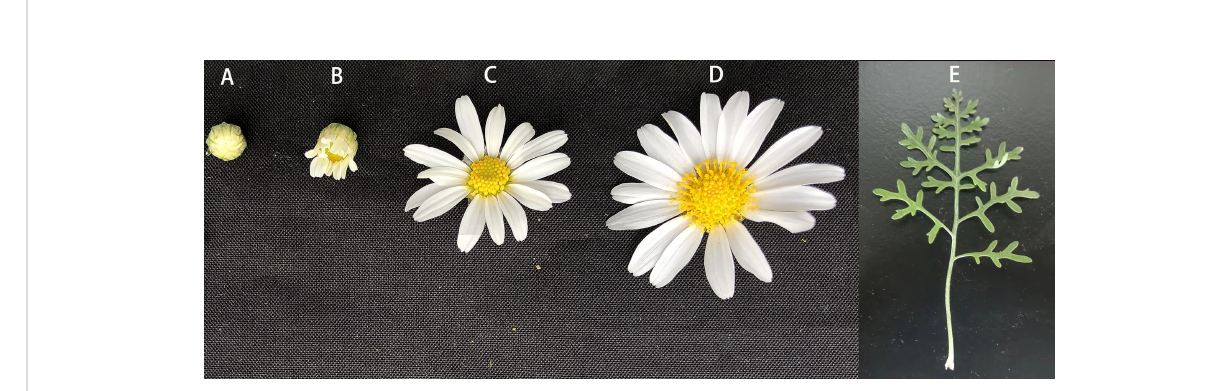
FIGURE 1 Opisthopappus longilobus samples used for the transcriptome and metabolome analyses. (A – E) Bud, in fl orescences at the exposure, initial opening, and blooming stages, and a leaf,